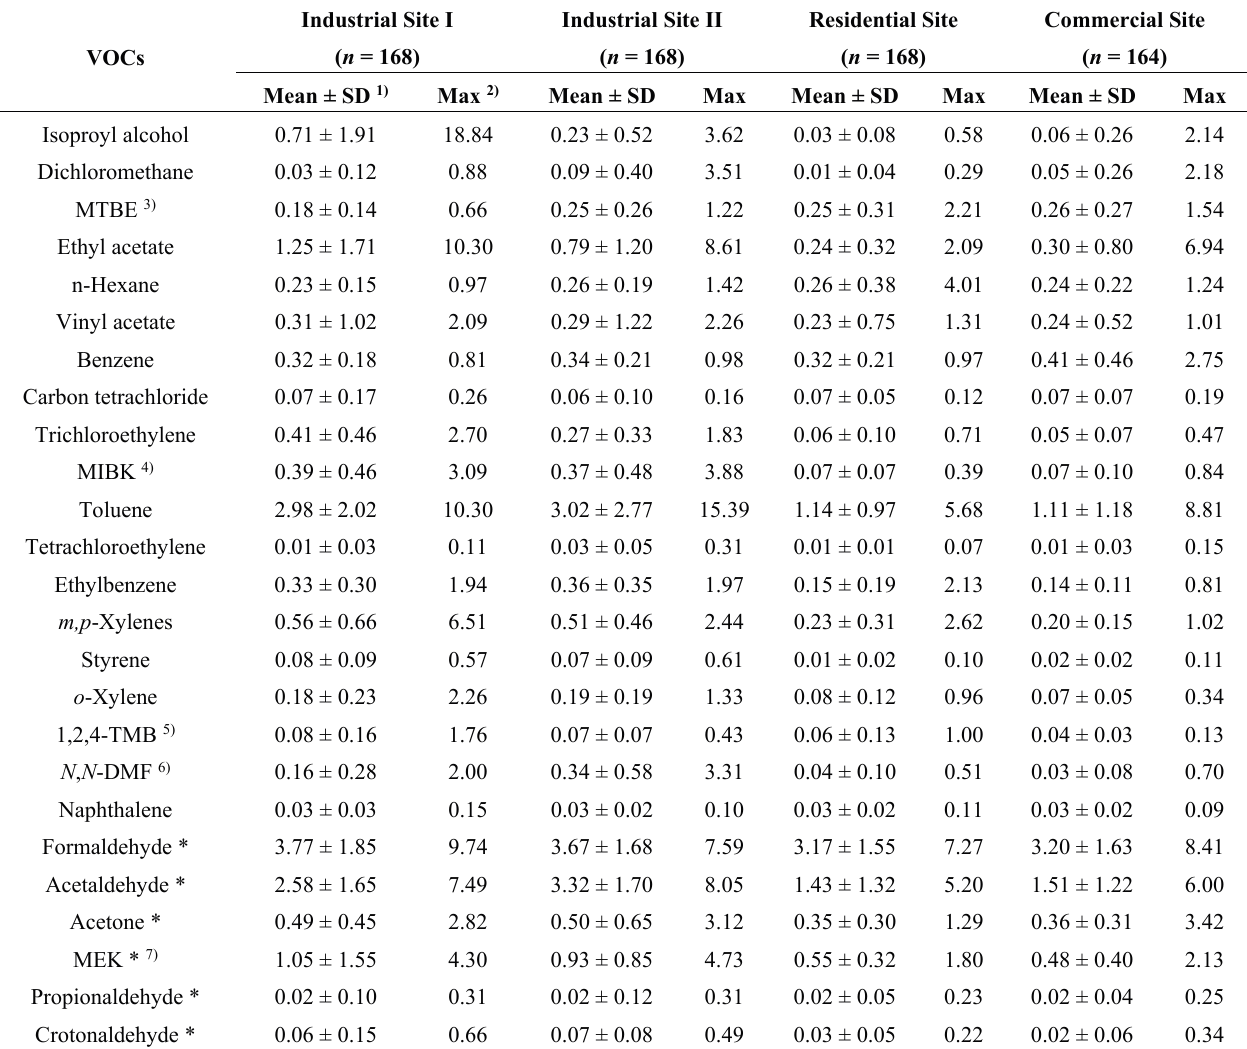
Table 4. Concentrations (in ppb) of selected VOCs in Gumi City during